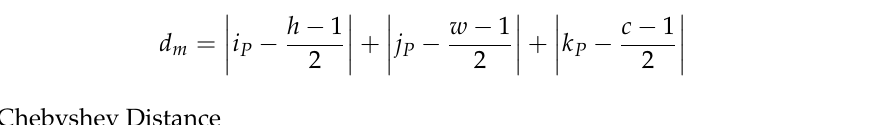
( a ) ( b ) Figure 5. Plot of the weights of the AAW method, the exponential weighted distance ( a ) and the magnitude of the corre- sponding Fourier transformation ( b ) for the 32nd row of the 33rd slice. From left to right: AAW, exponential Chebyshev- distance-weighted (ECDW), exponential Manhattan-distance-weighted (EMDW), and exponential Euclidean-distance- weighted (EEDW). From the amplitude of FFT, we can find that the AAW method and ECDW retain some high-frequency information and cannot remove the grid-like artifacts to a greater degree. 2.3. The Process of Patch Fusio In our work (as illustrated in Figure 6), we extract overlapping patches via a sliding window with a stride of s .